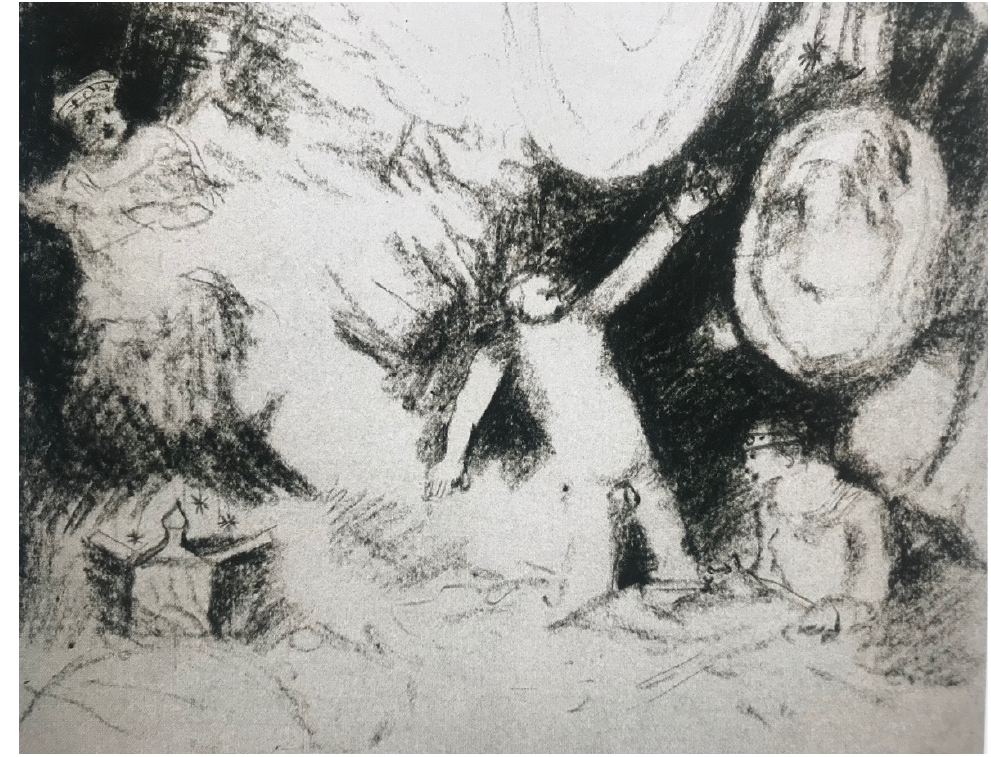
Figure 12. Vasily Chekrygin, The Raising of the Dead , 1922, pencil and charcoal on paper, private collection.